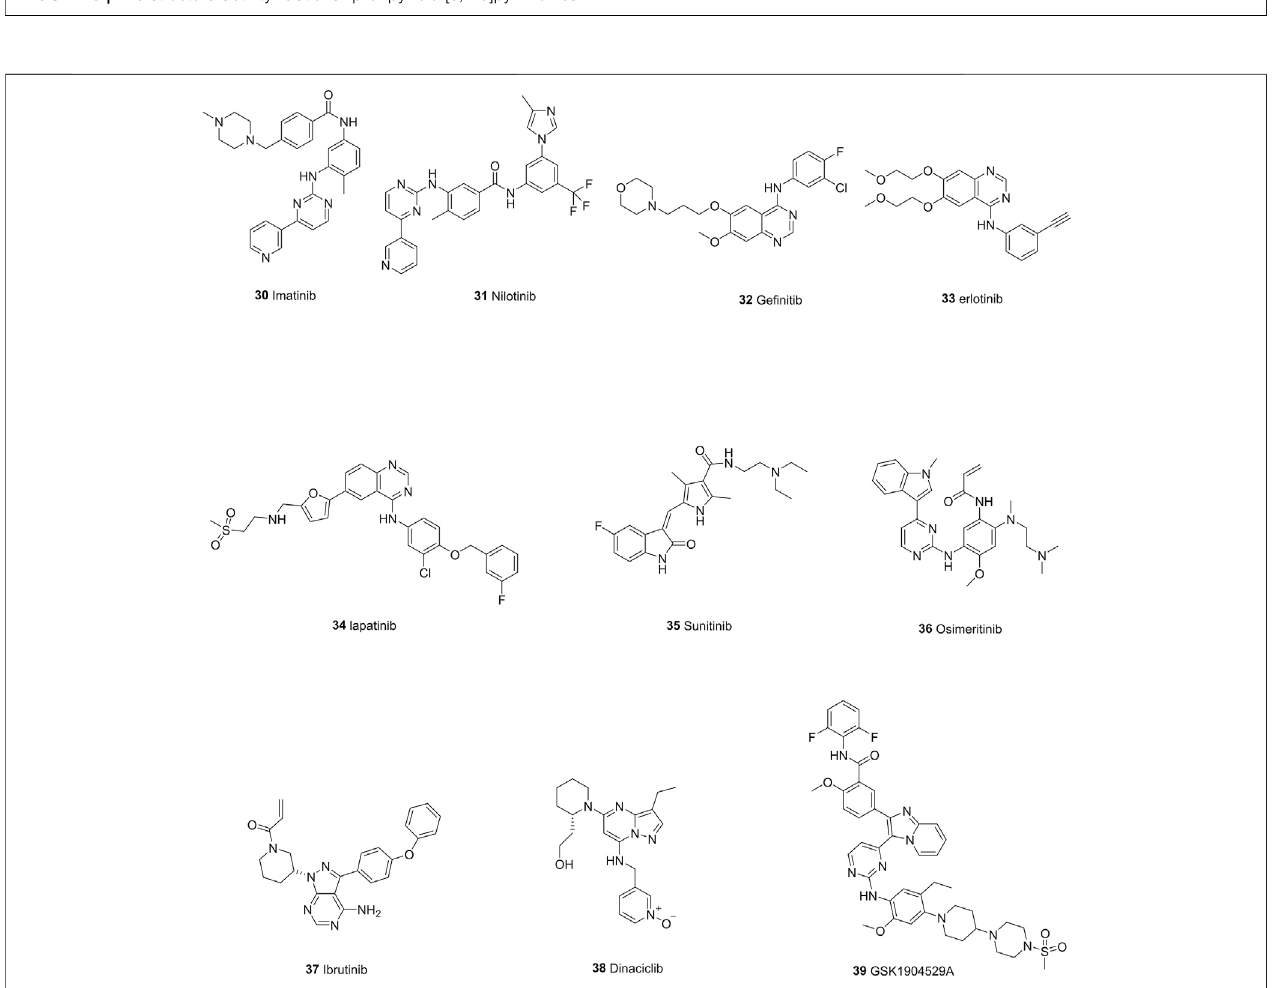
FIGURE 9 | The chemical structures of representative tyrosine kinase